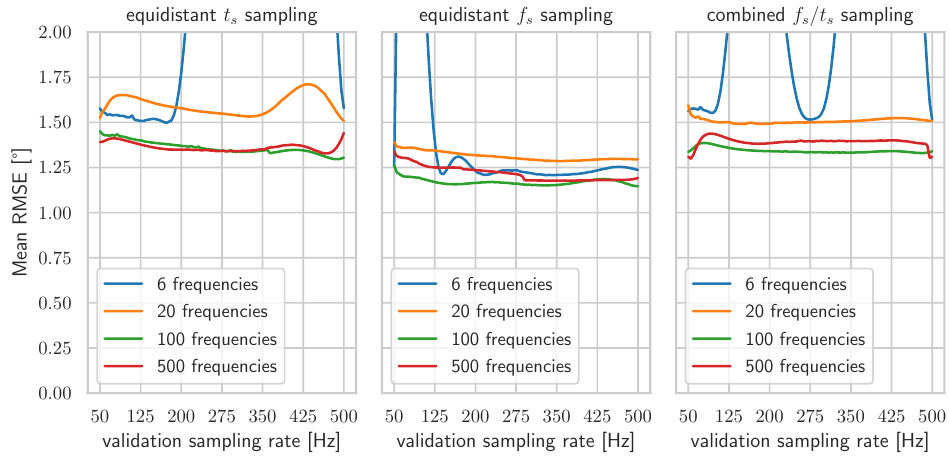
Figure 7. Comparison of time-aware networks with training data that was resampled to frequencies drawn equidistantly from sampling time t s , sampling rate f s , or both combined. At least 100 different frequencies are required to achieve high accuracy. The f s space models are the most accurate across the entire frequency